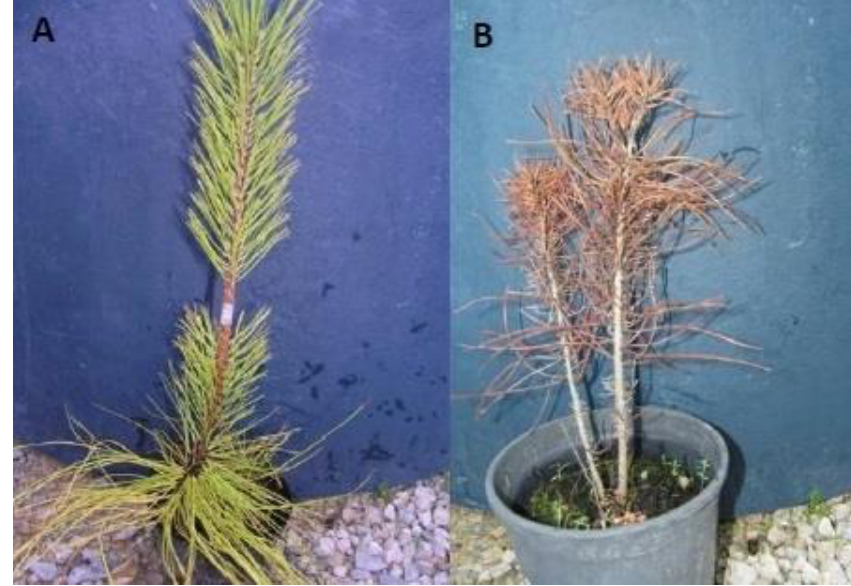
Figure 14. Pinus yunnanensis ( A ) and Pinus pinaster ( B ) individuals two months after infection with PWN (Trindade 2012). While Yunnan pine shows no signs of PWD, these are quite evident in maritime pine.